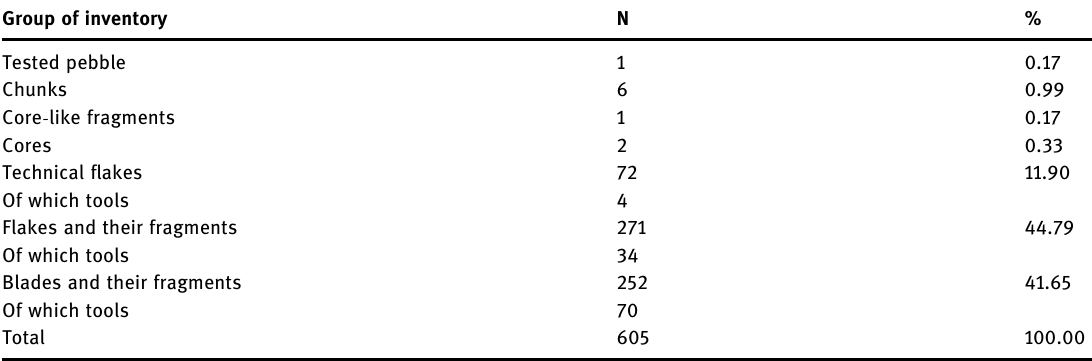
Table 2: Summary of the collection Group of inventory